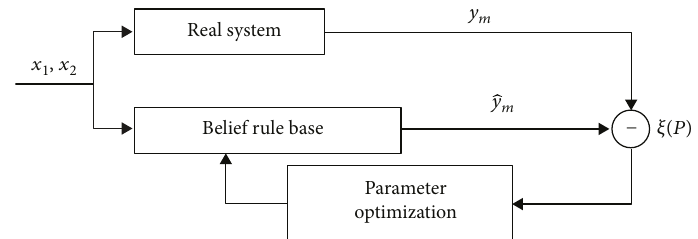
Figure 3: Basic ideas and processes of BRB system parameter